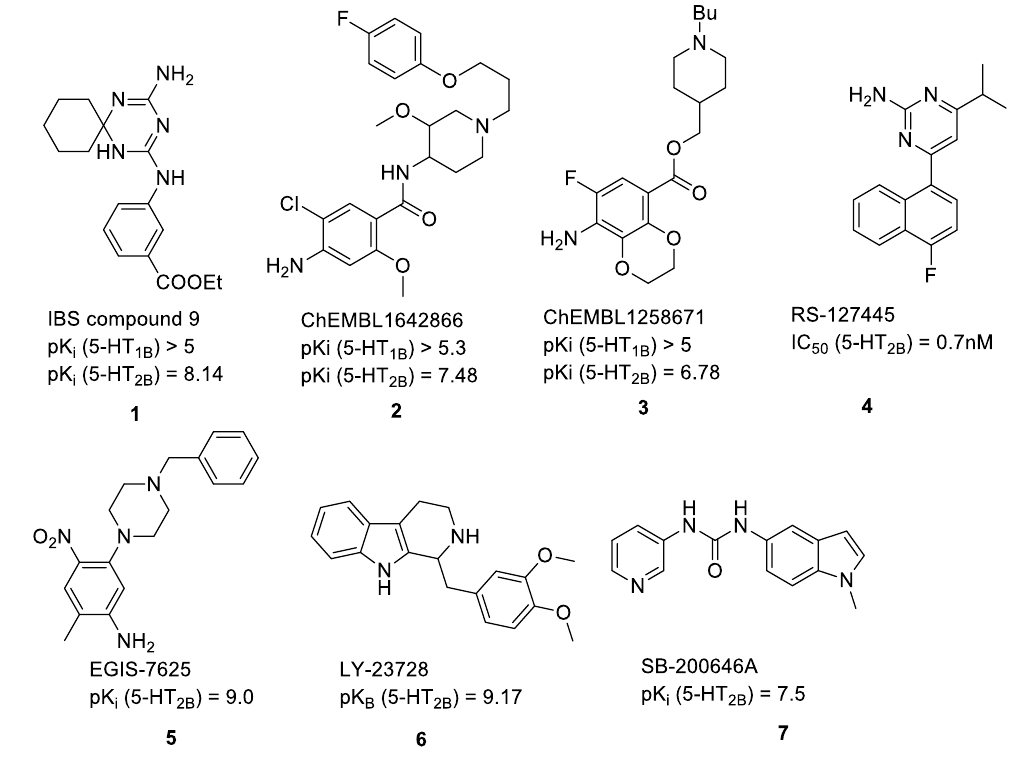
Figure 1. Representative 5-HT 2B R ligands (compounds 1 – 3 with available 5-HT 1B R and 5-HT 2B R binding affinity data, and examples of clinical candidates 4 – 7 ).